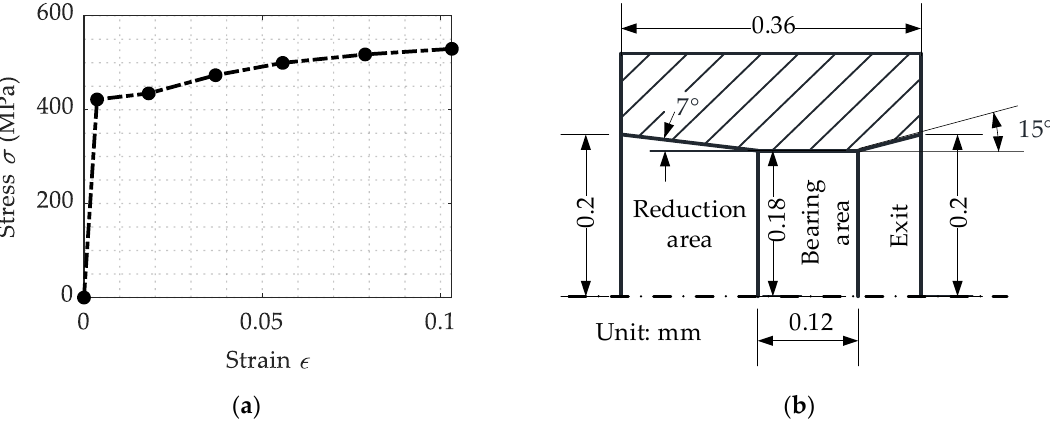
Figure 2. Material property and geometry definition of the die specified in the simulation program: ( a ) Stress-strain curve of TA2 commercial pure titanium in FE simulation; ( b ) Structure and dimensions about the diamond nib of the wire drawing die.